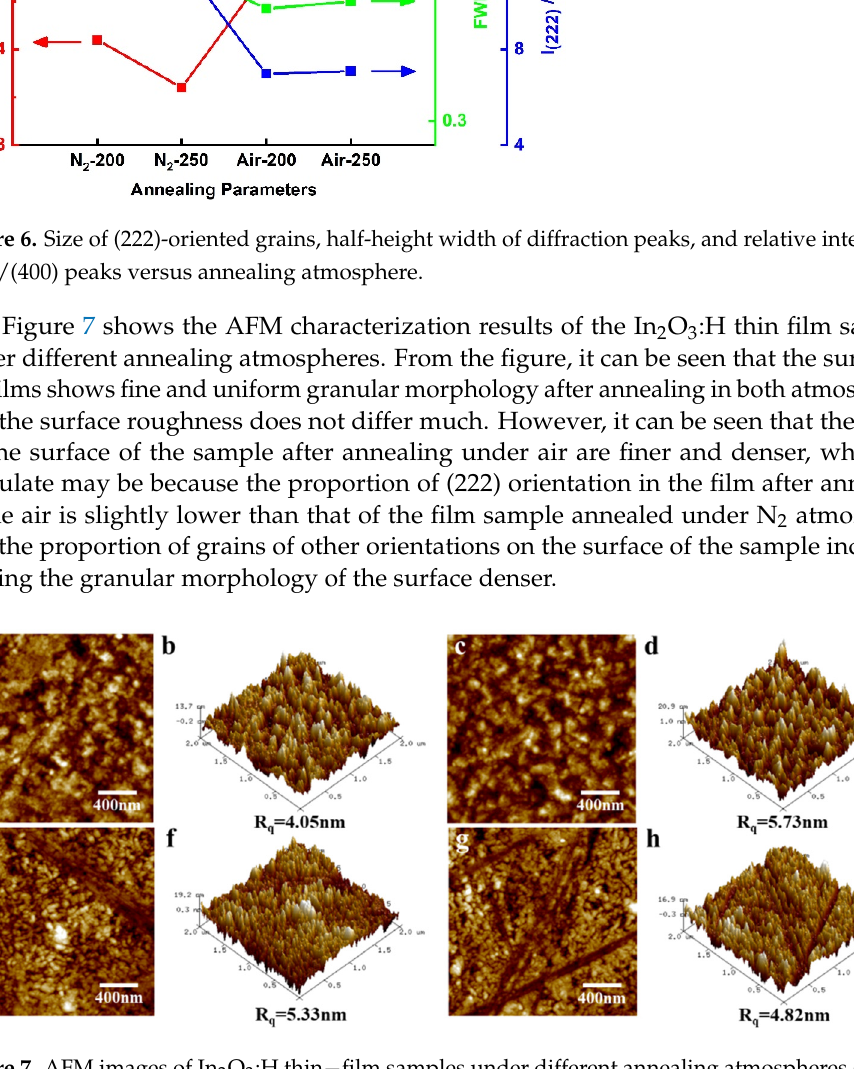
Figure 7. AFM images of In 2 O 3 :H thin − film samples under different annealing atmospheres ( a , b ) N 2 200 °C, ( c , d ) N 2 250 °C, ( e , f ) air 200 °C, ( g , h ) air 250 °C.